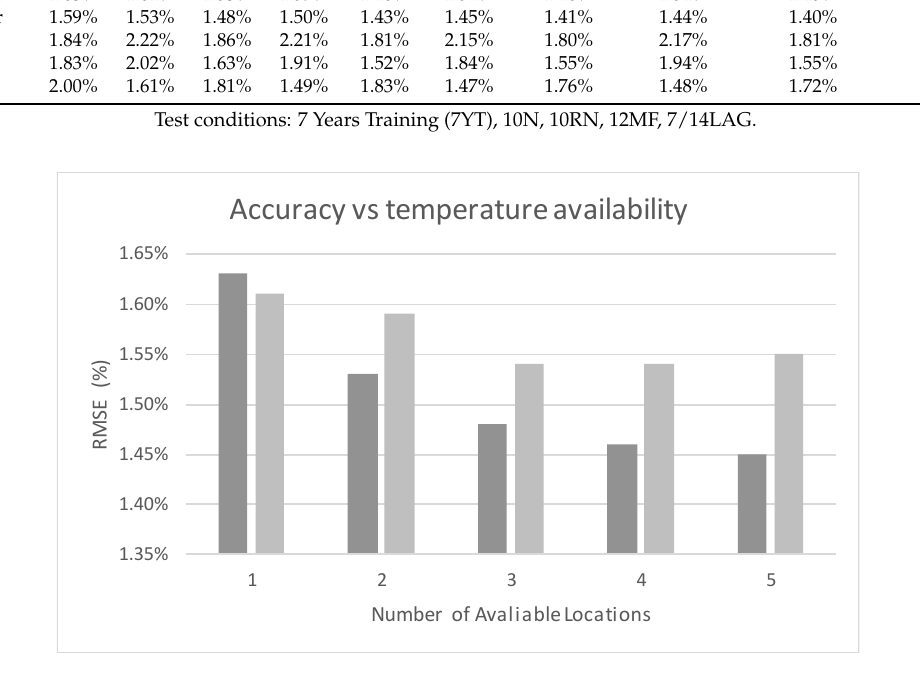
Table 4. Forecasting error (RMSE) with different HDD threshold adjustment in Barcelona.